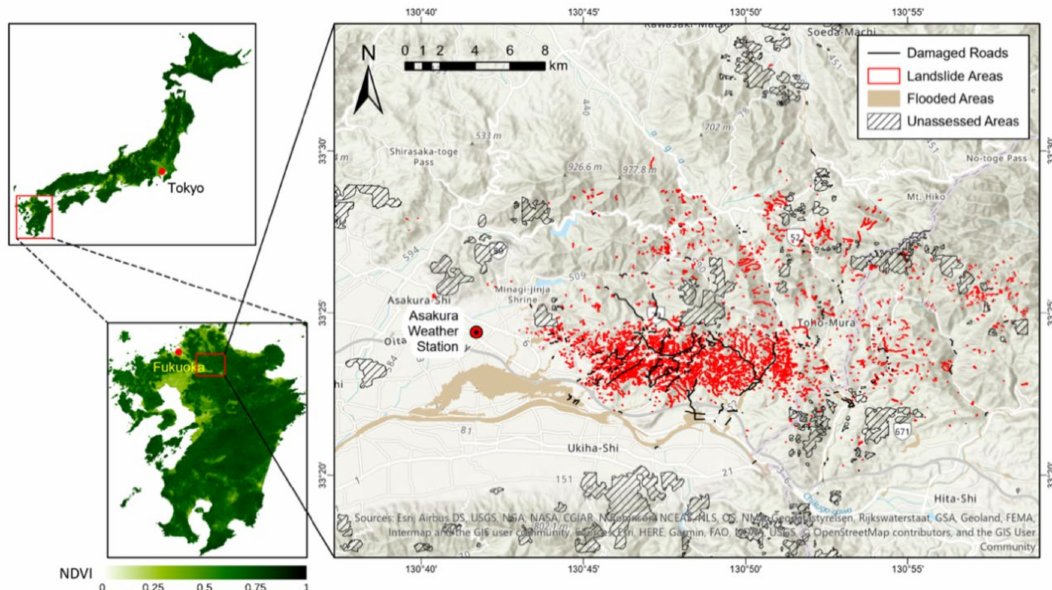
Figure 1. Map of study area encompassing the eastern part of Asakura-shi, Fukuoka and the northern part of Hita-shi, Oita, Japan. The vector layer delineating landslide areas, damaged roads, and flooded areas along with unassessed areas was obtained from the Geospatial Information Authority of Japan (GSI) [24] (see Section 2.3). The Himawari-8 AHI smoothed and gap-filled NDVI image of 21 June 2017 was used in the upper-left and lower-left frames. The coastline vector dataset used in those two frames was obtained from the GSI [25]. The map was created with ArcGIS ® software (ArcGIS ® Pro 2.4.1, Esri, Redlands, CA, USA, http: // www.esri.com).